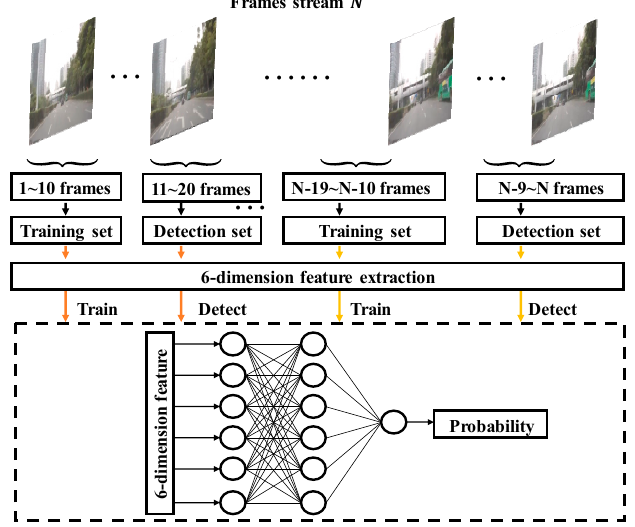
Figure 7. Retrain the backpropagation (BP) neural network for each 10 frames.